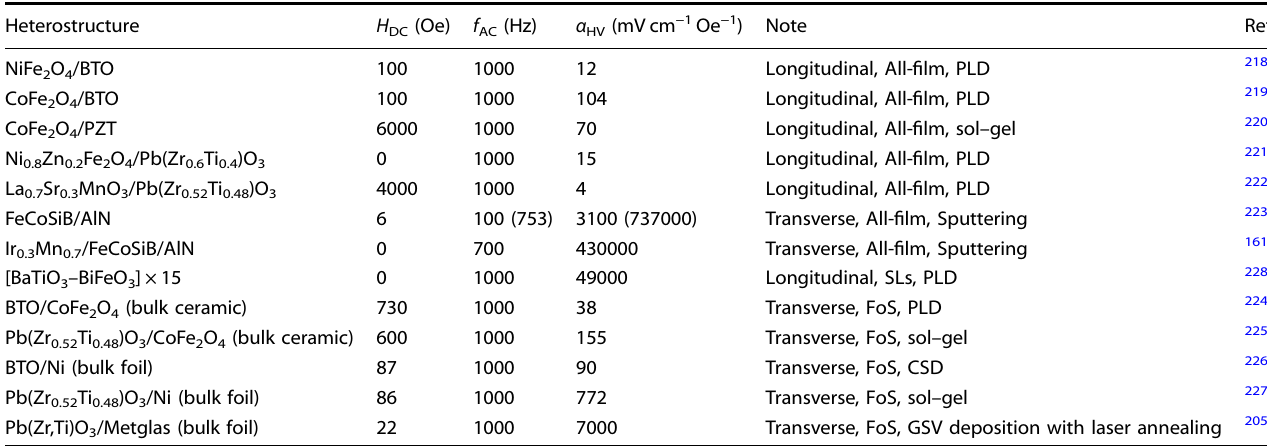
fi eld is applied parallel to electric 3 -based dielectric layers. The DC magnetic HV H by magnifying the induced voltage